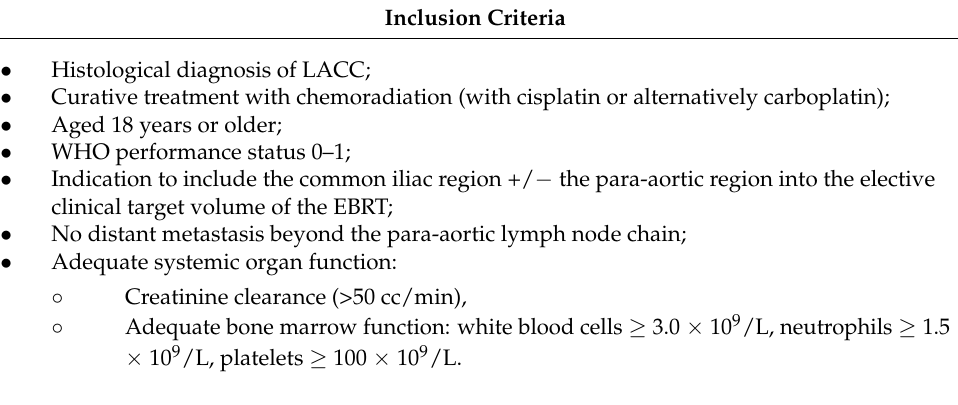
Table 1. Inclusion and exclusion criteria for participation in the PROTECT trial. Inclusion